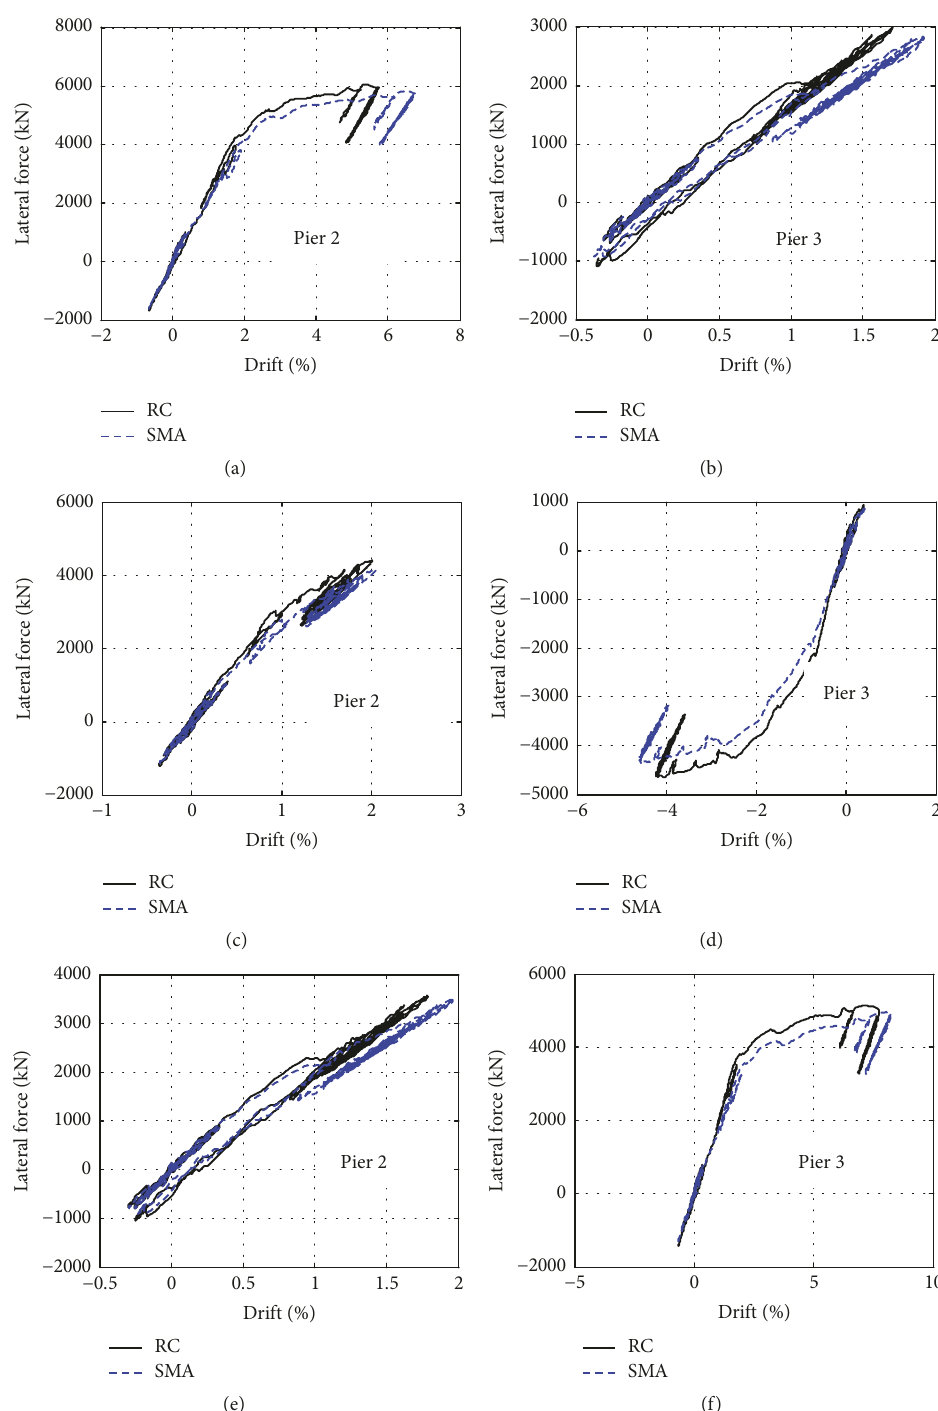
Figure 15: Calculated force displacement hysteresis of the column with double amplified motions: (a) Pier 2 in Case 1, (b) Pier 3 in Case 1, (c) Pier 2 in Case 2, (d) Pier 3 in Case 2, (e) Pier 2 in Case 3, and (f) Pier 3 in Case 3.